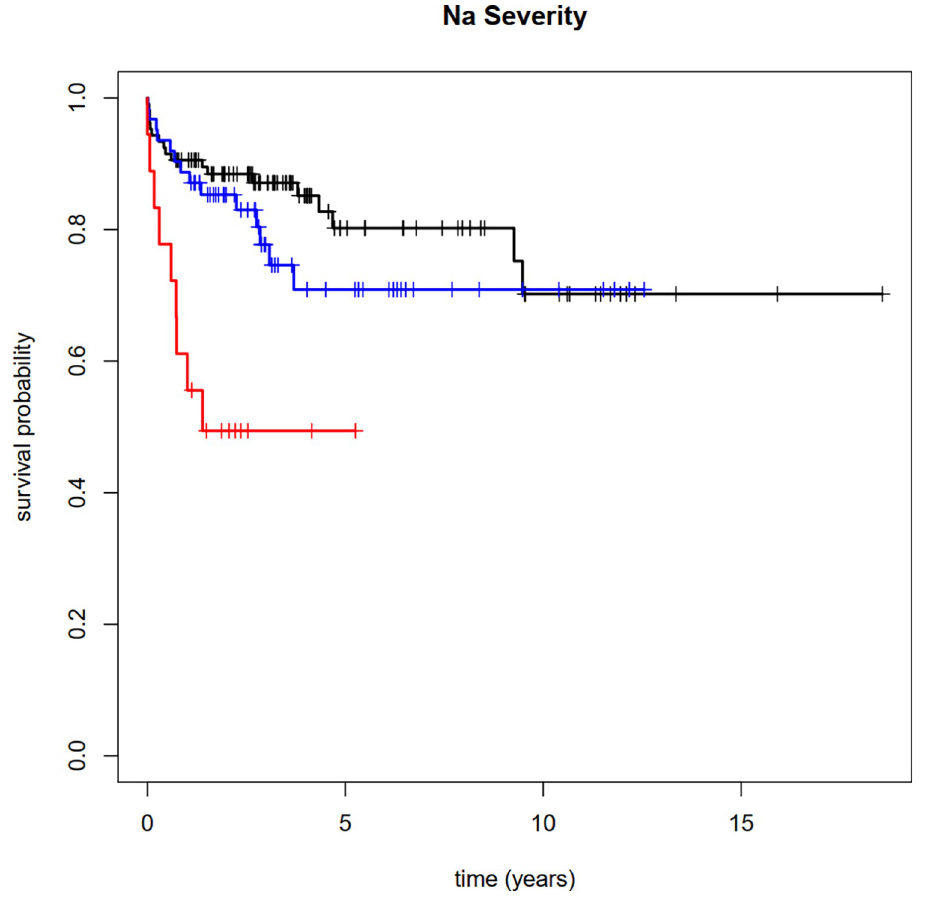
Fig 3. Mortality risk in patients with TB. The graph details the mortality rates of patients with TB with moderate to profound hyponatremia (red), mild hyponatremia (blue), and non-hyponatremic patients (black).